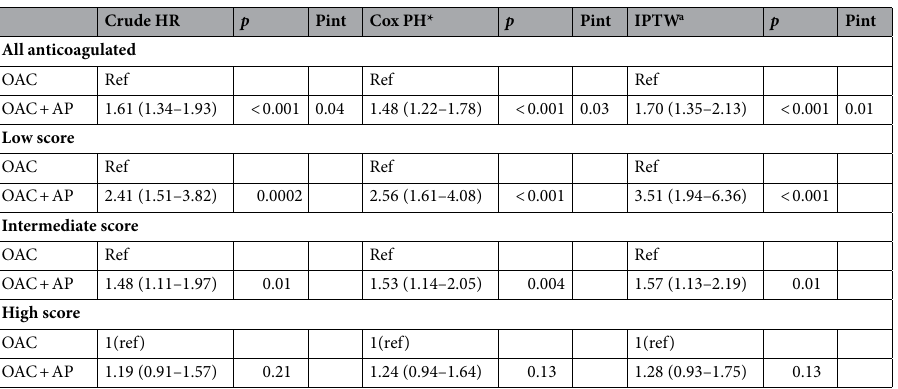
Table 4. Association of OAC vs OAC + AP with primary outcome according to the CHA2DS2-VASc score subgroup. *Adjusted variables: age, NIHSS scores, dyslipidemia, smoking, prior anticoagulant use, prior statin use, prior antihypertensive use, prior antidiabetic use, LAD, glucose, SBP, LDL-cholesterol, multiple lesions, reperfusion therapy, stroke mechanism, CHA2DS2-VASc score. a Weighted Cox proportional hazards model with robust standard